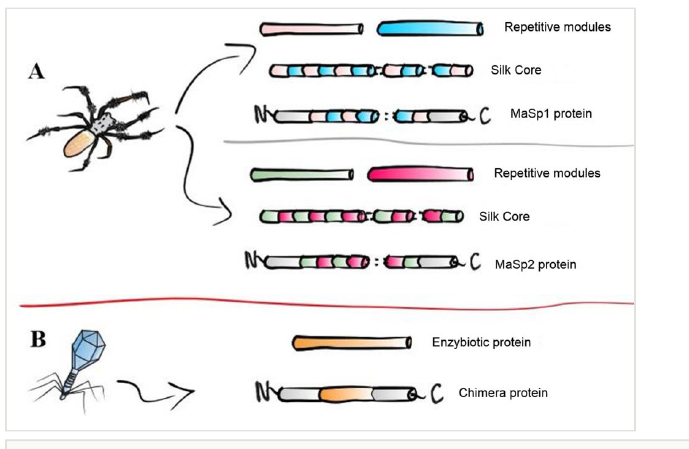
Figure 2. Schematic representation of spider silk proteins and chimeric protein. A : MaSp1 - Major ampullate spidroin 1, MaSp2 - Major ampullate spidroin 2 B : Chimeric protein of a enzybiotic with N and C terminals domains of spider silk